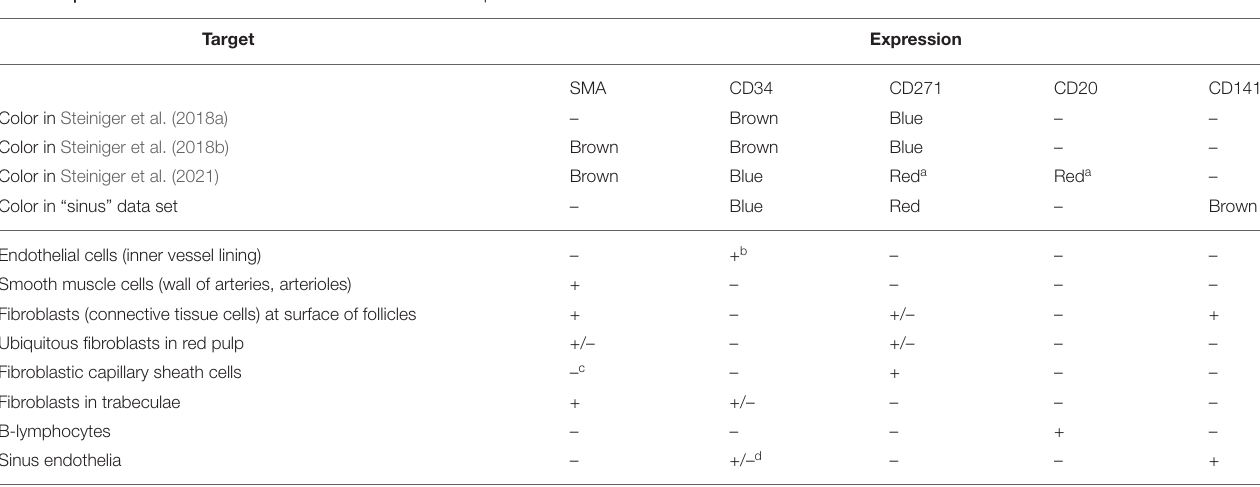
TABLE 1 | Cell distribution of the molecules detected in human